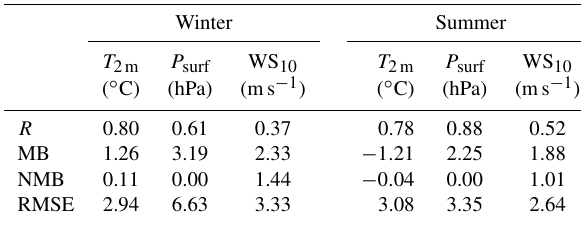
Table 3. Pearson’s correlation coefficient ( R ), mean bias (MB), nor- malized mean bias (NMB), and root mean squared error (RMSE) between the modelled by the WRF-Chem model and observed hourly values of temperature at 2m, wind speed at 10m, and sur- face pressure averaged over all stations. For all stations during both periods, the p value <